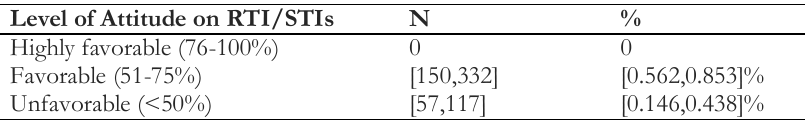
Table 4. Distribution of level of women’s attitude on RTI/STIs.